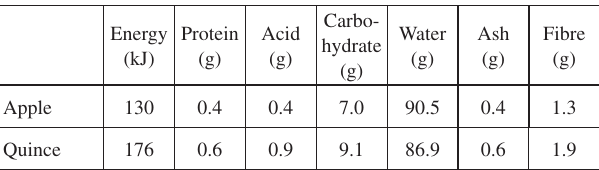
Table 1. Main nutritional composition of quince and apple (‘Jonathan’) fruits in 100 g fresh weight ( Bíró and Lindner ,